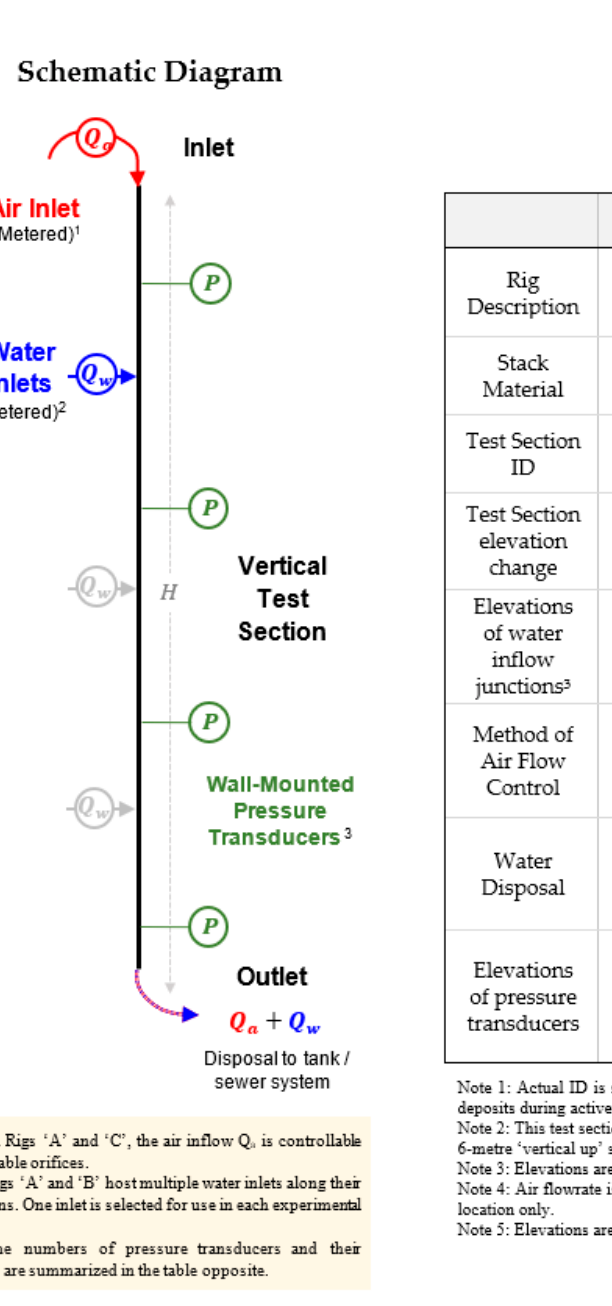
Figure 4. ( a ) Schematic diagram of gravity-driven annular downflow test rigs [28–30]. ( b ) Table summarizing key features.